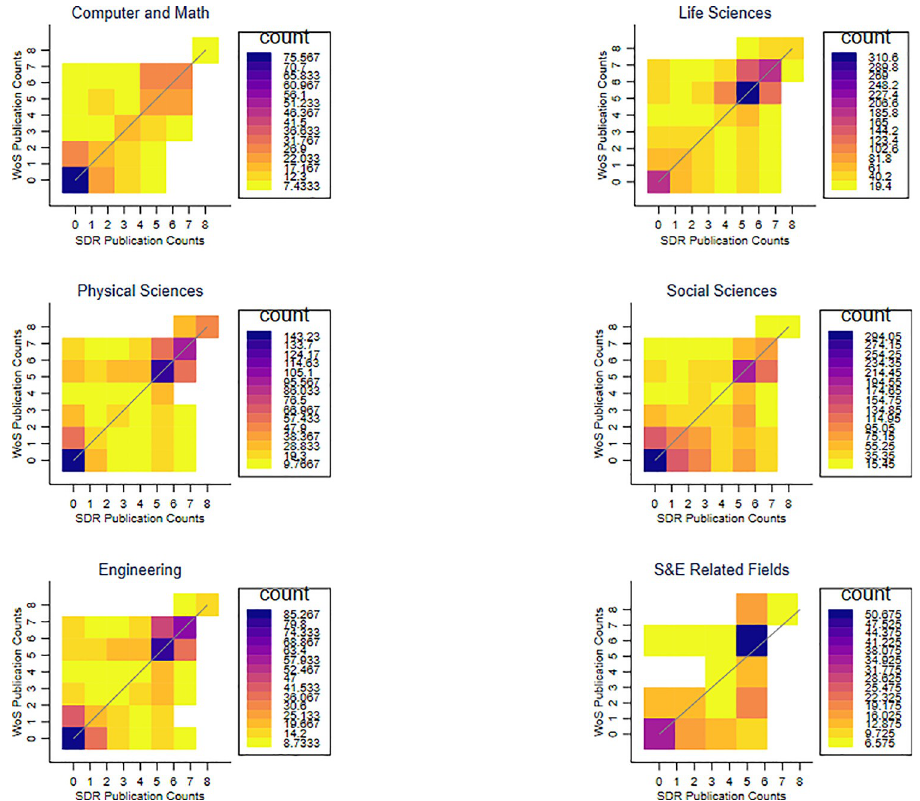
Fig 3. Relationship between the SDR and WoS publication counts, by research field. Notes: This figure shows the joint distribution of publication counts from the two sources: SDR and WoS from 1998–2003 by field. The colors represent the weighted sample size of each cell. Cells with fewer than 5 observations, including no observations, were excluded. There are 8 research field categories in the 2003 survey, and the 7 th (“Non-S&E Fields) and 8 th (Other Categories) were excluded due to small sample